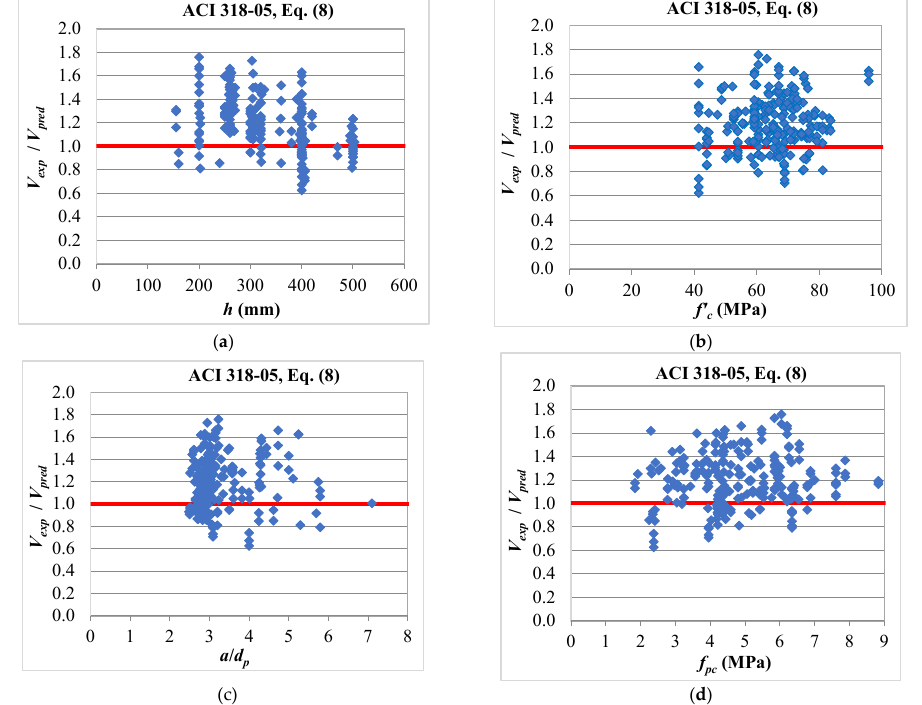
Figure 5. Predictions of the ACI 318-05 design equation against ( a ) total thickness, ( b ) concrete compressive strength, ( c ) shear span to depth ratio, and ( d ) compressive stress due to the fully effective prestressing force.